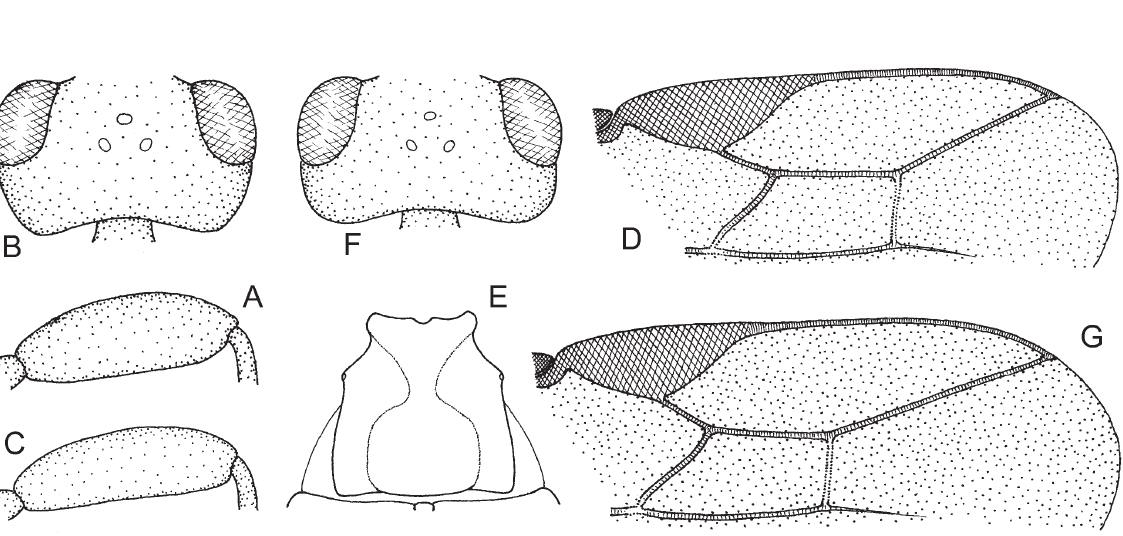
Fig. 9. Bracon ( Lucobracon ) erraticus Wesmael, 1838 (A: ♀ paralectotype, B-E: var. 1, ♀ paralectotype, F -G: var . superciliosus (Wesmael, 1838), ♀ holotype). A . Hind femur. B . Head in dorsal view. C . Hind femur. D . Distal part of right forewing. E . First tergite. F . Head in dorsal view. G . Distal part of right